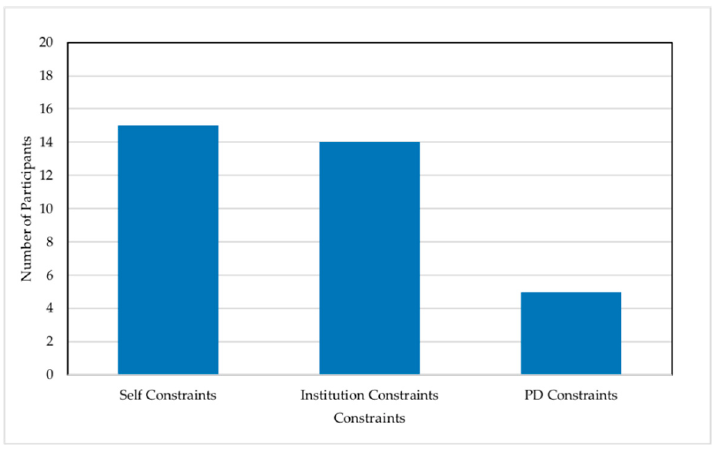
Figure 8. The frequency of emerging themes for the code constraints.